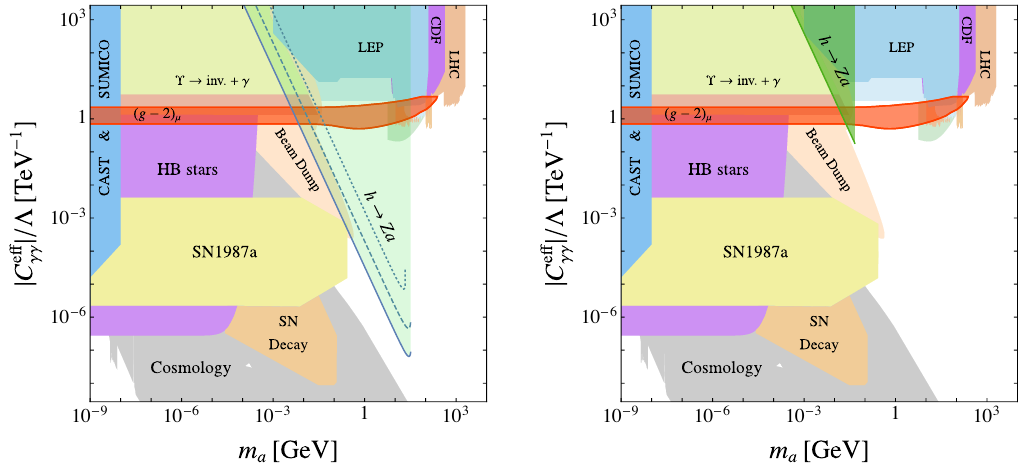
Figure 16 . Constraints on the ALP mass and coupling to photons derived from various experiments (colored areas without boundaries, adapted from [24]) along with the parameter regions that can be probed using the Higgs decays h Za ‘ + ‘ (cid:0) (cid:13)(cid:13) . The left panel shows the reach of LHC Run-2 ! ! with 300 fb (cid:0) 1 of integrated luminosity (shaded in light green). We require at least 100 signal events. The contours correspond to C e(cid:11) = (cid:3) = 0 : 72 TeV (cid:0) 1 (solid), 0 : 1 TeV (cid:0) 1 (dashed) and 0 : 015 TeV (cid:0) 1 Zh j j (dotted). The red band shows the preferred parameter space where the ( g 2) (cid:22) anomaly can be (cid:0) explained at 95% CL. The right panel shows the regions excluded by existing searches for h Z(cid:13) ! (shaded in dark green), where we assume C e(cid:11) = (cid:3) = 0 : 72 TeV (cid:0) 1 Zh j j